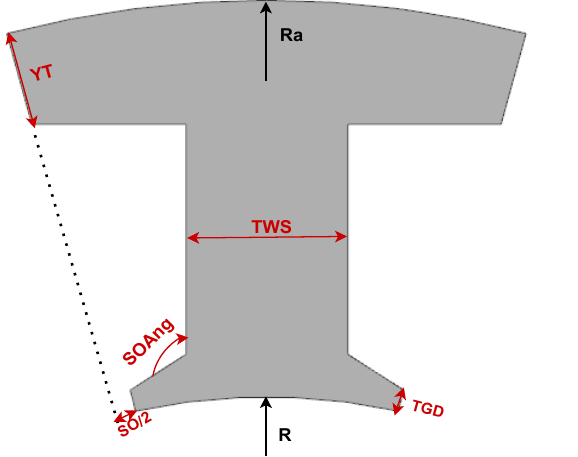
Figure 2. Stator cross-section parameterization where DOFs marked with black are kept fixed and the DOFs marked with red are varied to construct the machine learning model